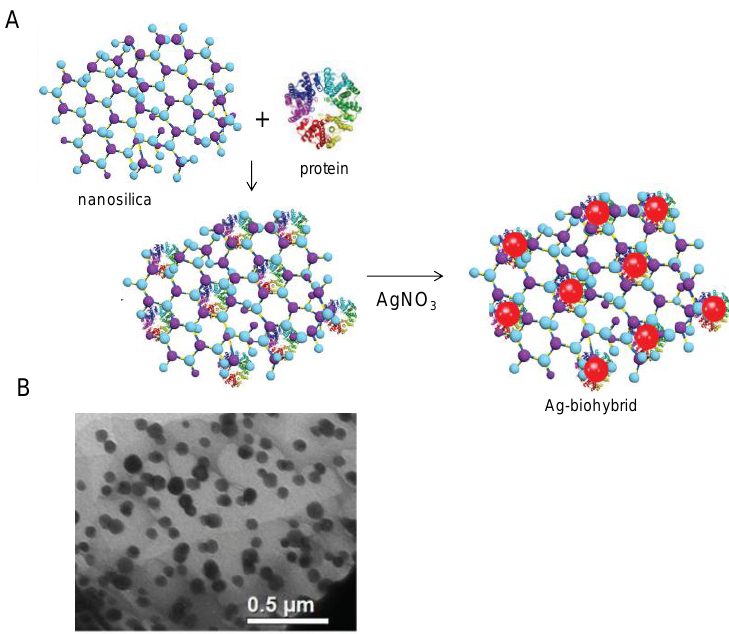
Figure 8. Synthesis of Ag-biohybrid. ( A ) Scheme of the formation of the nanostructure; ( B ) TEM of Ag-nanohybrid. Reproduced with permission from [39]. Copyright the Royal Society of Chemistry, 2013.